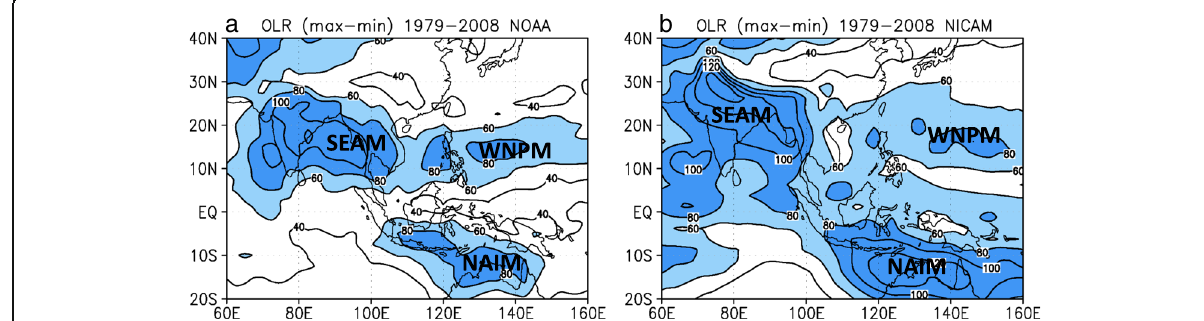
Fig. 6 Horizontal distribution of OLR comparing Asian monsoon between simulations and observation. a National Oceanic and Atmospheric Administration (NOAA) OLR and b OLR of the NICAM AMIP-type simulation defined by the difference between the annual maximum and minimum OLR in the pentad mean climatology (1979 – 2008). The northern Australia-Indonesia monsoon (NAIM), Southeast Asian monsoon (SEAM), and western North Pacific monsoon (WNPM) are identified after Murakami and Matsumoto